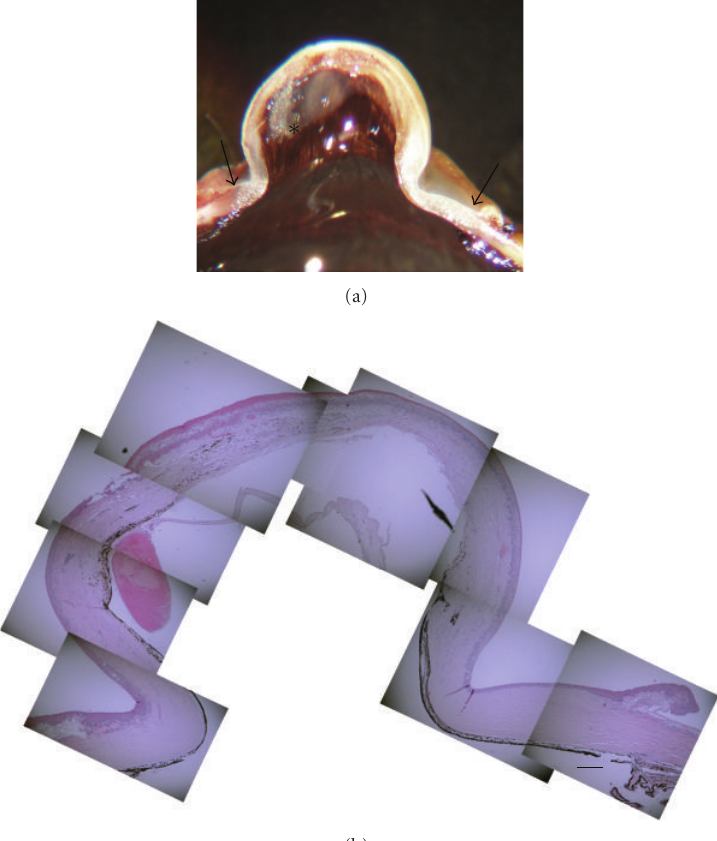
Figure 3: (a) Gross examination of the globe showed a large corneal staphyloma and very small remnant lens. Arrow: corneal limb. Asterisk; lens. (b) Histology of the corneal protrusion with HE staining. Bar: 300 μ